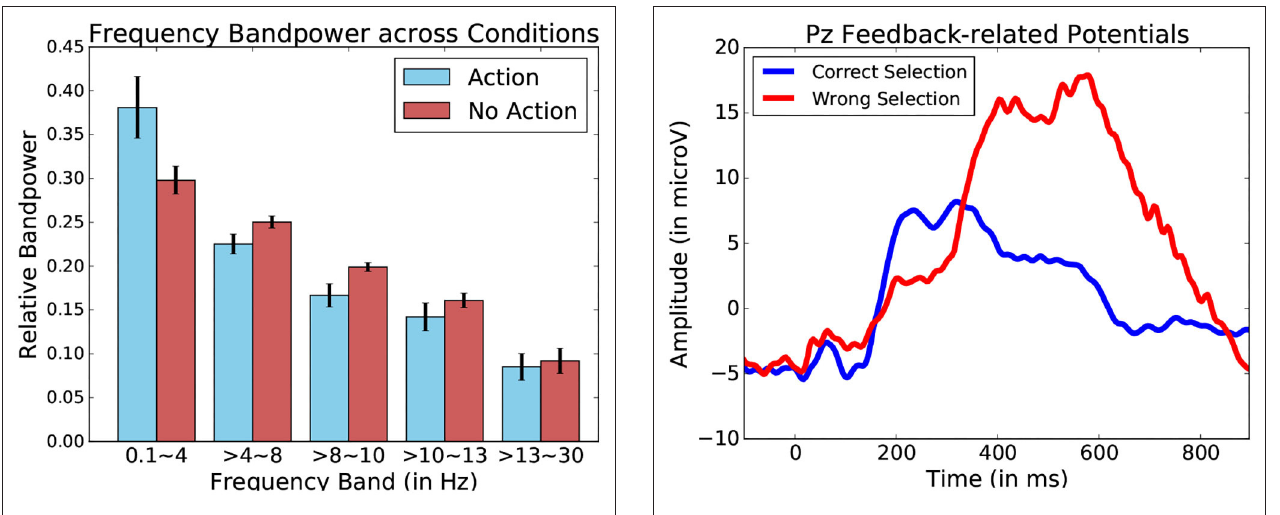
FIGURE 13 | Relative frequency bandpower depending on the presence or absence of keyboard presses. Data from one participant was used for this Figure.